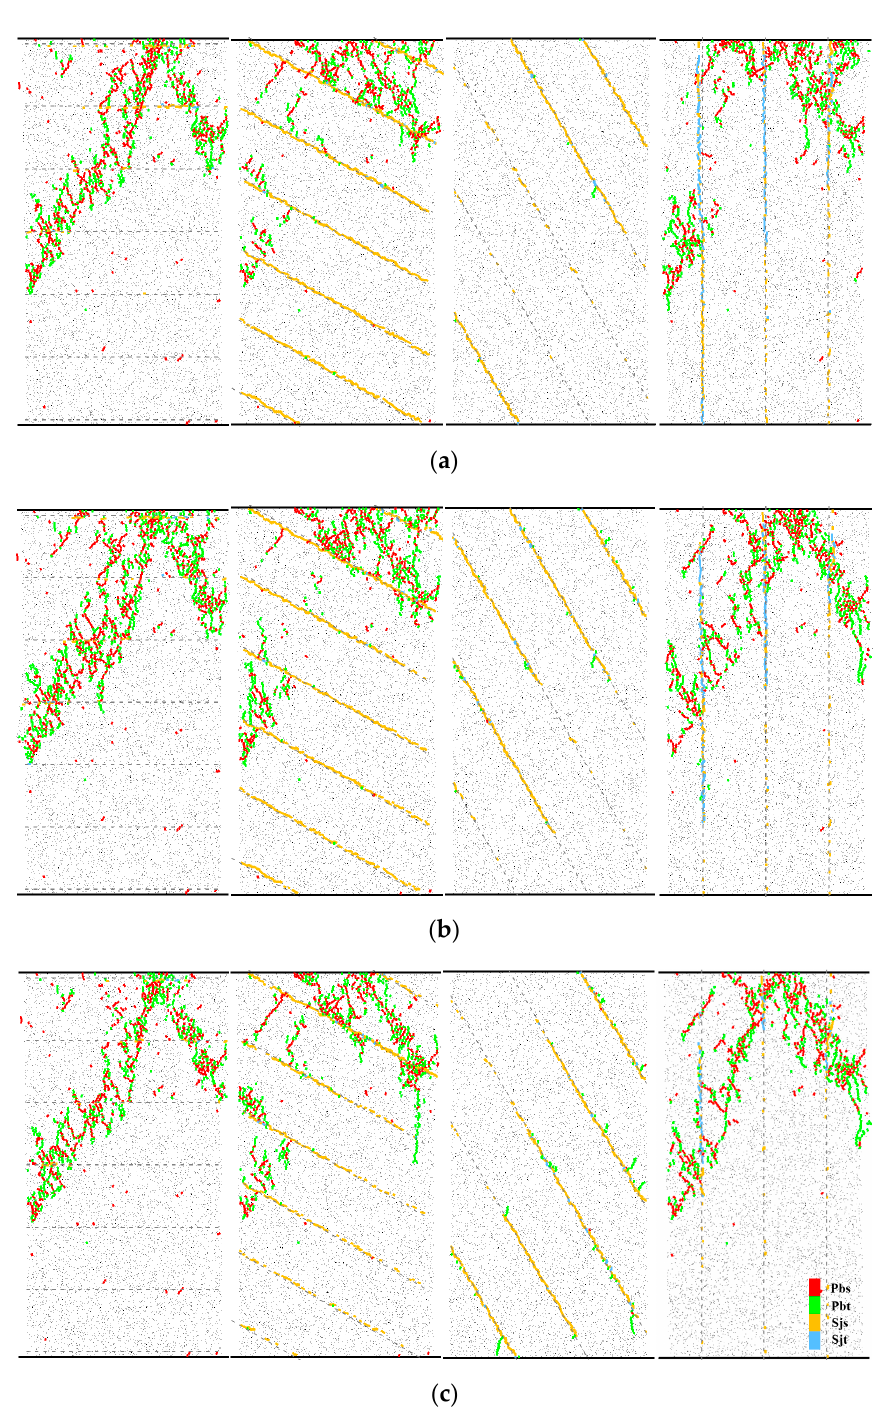
Figure 10. Distributions of crack type at different JSRs: ( a ) JSR = 0.8; ( b ) JSR = 1.0 (datum case); ( c ) JSR = 1.2.